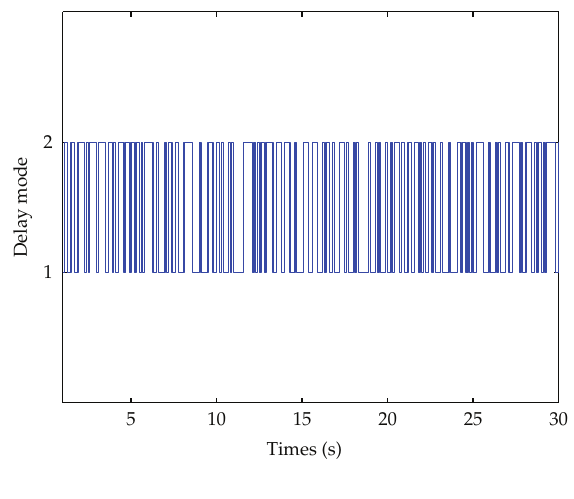
Figure 2: Delay jumping mode.